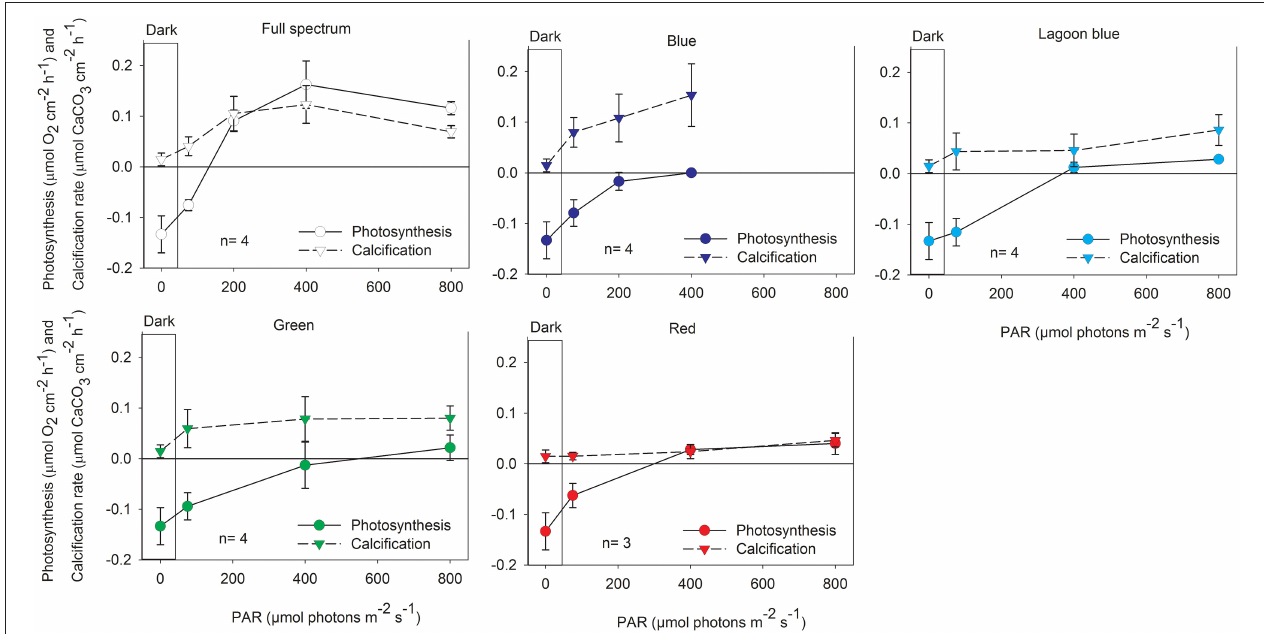
FIGURE 2 | Net photosynthesis and calcification (mean ± SD) of the coral A. variabilis exposed to increasing intensities of control, full spectrum, blue, lagoon blue, green, or red light.